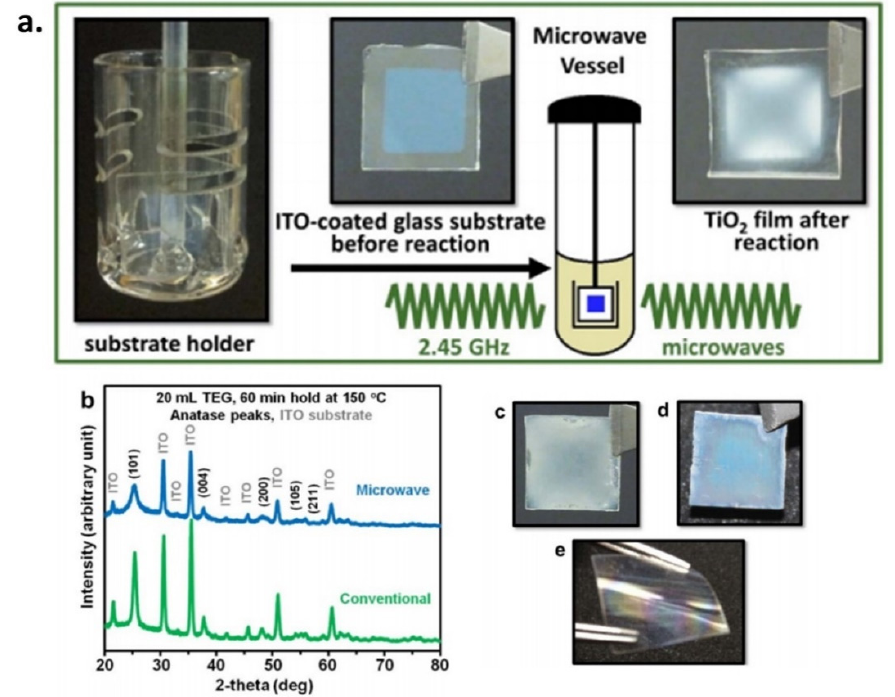
Figure 3. ( a ) Schematic representation of microwave reaction to grow thin titanium dioxide (TiO 2 ) film. ( b ) XRD spectra of TiO 2 -indium tin oxide (ITO)-coated glass. The strong peaks were associated with the anatase phase, in particular the (101) peak. ( c ) Microwave-grown TiO 2 film on ITO-coated glass. ( d ) Microwave-grown TiO 2 film on Alluminium-coated glass. ( e ) Microwave-grown TiO 2 film on ITO-coated Polyethylene terephthalate (PET). Adapted from reference [79].